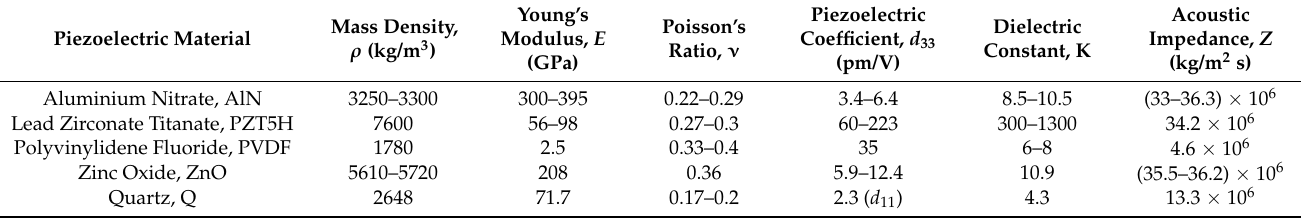
Table 2. Parameters of the piezoelectric